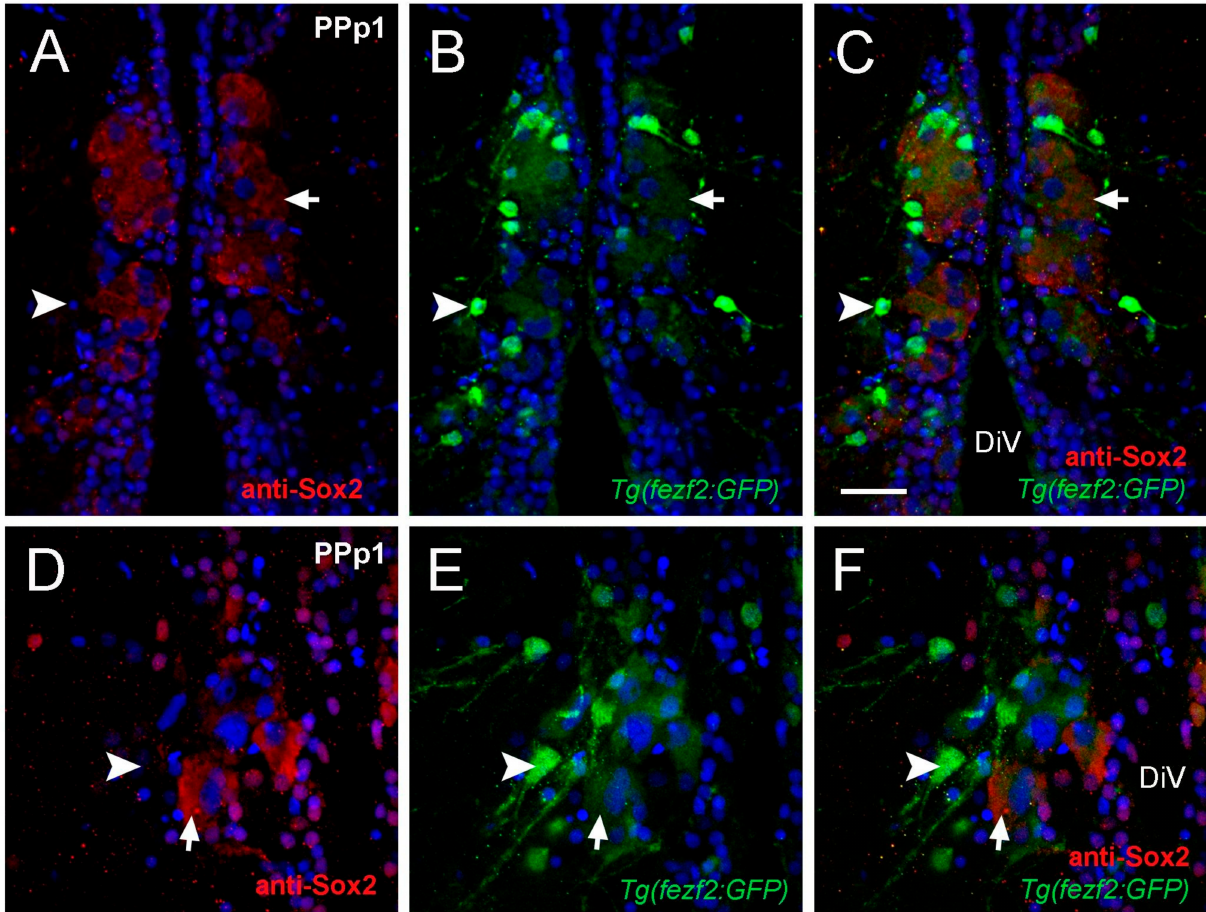
Figure 3. Cytoplasmic Sox2 cells co-localize with Fezf2:GFP. ( A – F ) Transverse cryosections of 20 µ m of PPp1. ( A – C ) Large cytoplasmic Sox2+ cells express Fezf2:GFP (arrow), smaller cells Fezf2:GFP do not co-localize with cytoplasmic Sox2 (arrowheads). (A) Anti-Sox2 labeling. ( B ) Fezf2:GFP expression. ( C ) Merged image. Confocal images of ( D ) Sox2+ cells ( E ) Fezf2:GFP+ cells, ( F ) Merge. Cytoplasmic Sox2+ cells (red, arrow) express Fezf2:GFP (green, arrow), Small Fezf2:GFP+ cells (green, arrowhead) are Sox2 (( D , F ) arrowheads). Sections labeled with DAPI (blue). Diencephalic ventricle (DiV). Scale bar: 30 µ